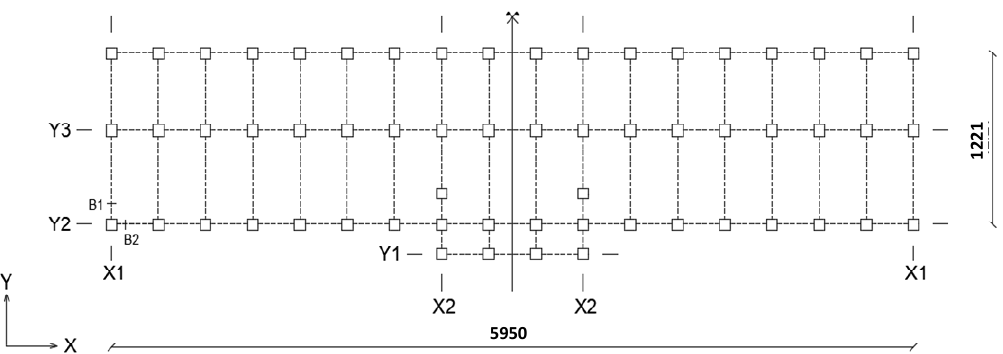
Figure 2. Scheme with main dimensions of the building in plant and identification of the main RC frames in X (X1, X2) and Y (Y1, Y2, Y3) directions. Dimensions reported in [cm].